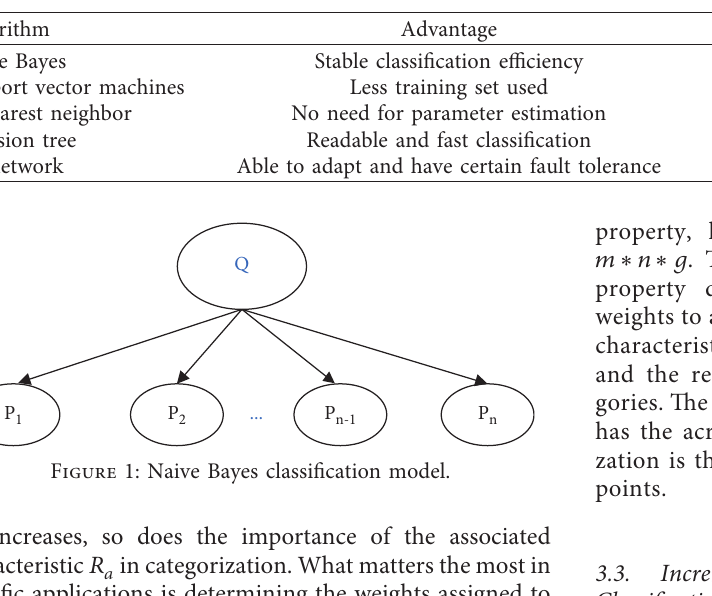
Table 1: Comparison and analysis of classification algorithms.